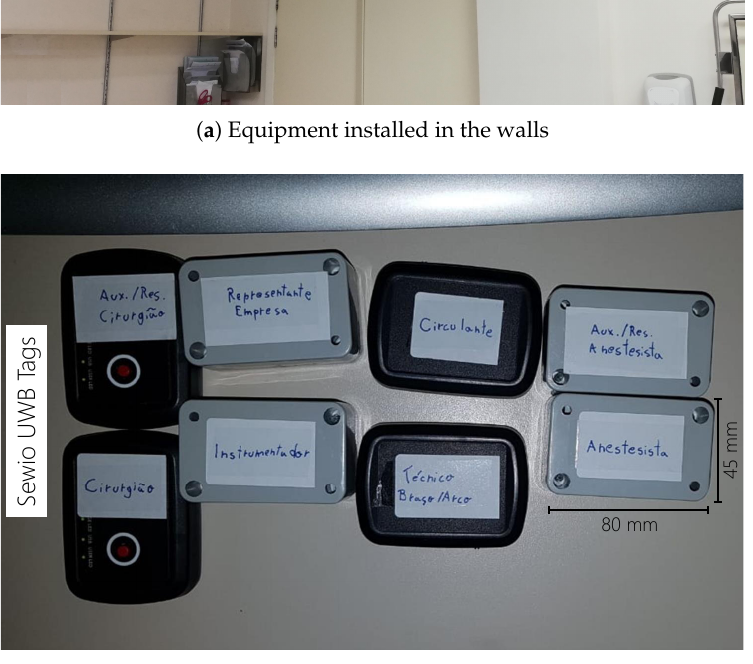
Figure 5. Deployment in a real hybrid operating room. The Sewio RTLS Studio runs in a virtual machine in a physical machine connected to the same network as the anchors. The figure depicts only two of three Data Gateways. The Core runs in a separate room and does not appear in the